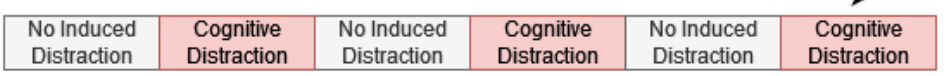
Figure 7. Experimental conditions during study 2. Each segment took approximately one minute.